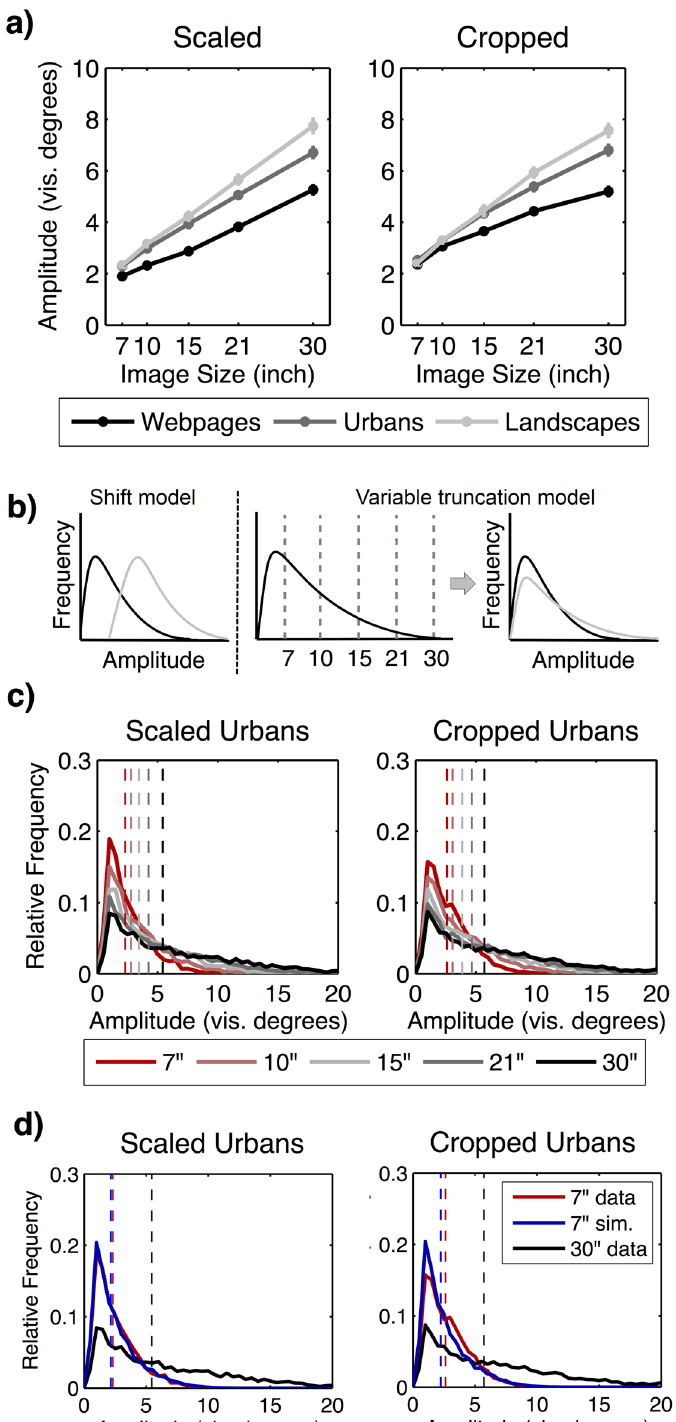
Figure 5. ( a ) Increase of the mean saccade amplitude across image sizes depending on image category and condition (scaled vs. cropped). Error bars indicate standard error of the mean. ( b ) Sketch of the two alternative models describing how the distribution of saccade amplitudes would change with varying image size. ( c ) Real distribution of saccade amplitudes on urban images for each image size in scaled and cropped conditions. Vertical dashed lines indicate the median saccade amplitude. ( d ) Real distribution of saccade amplitudes on 7” urban images and 30” urban images and the simulated distribution for 7” urban images based on saccades sampled from 30” urban